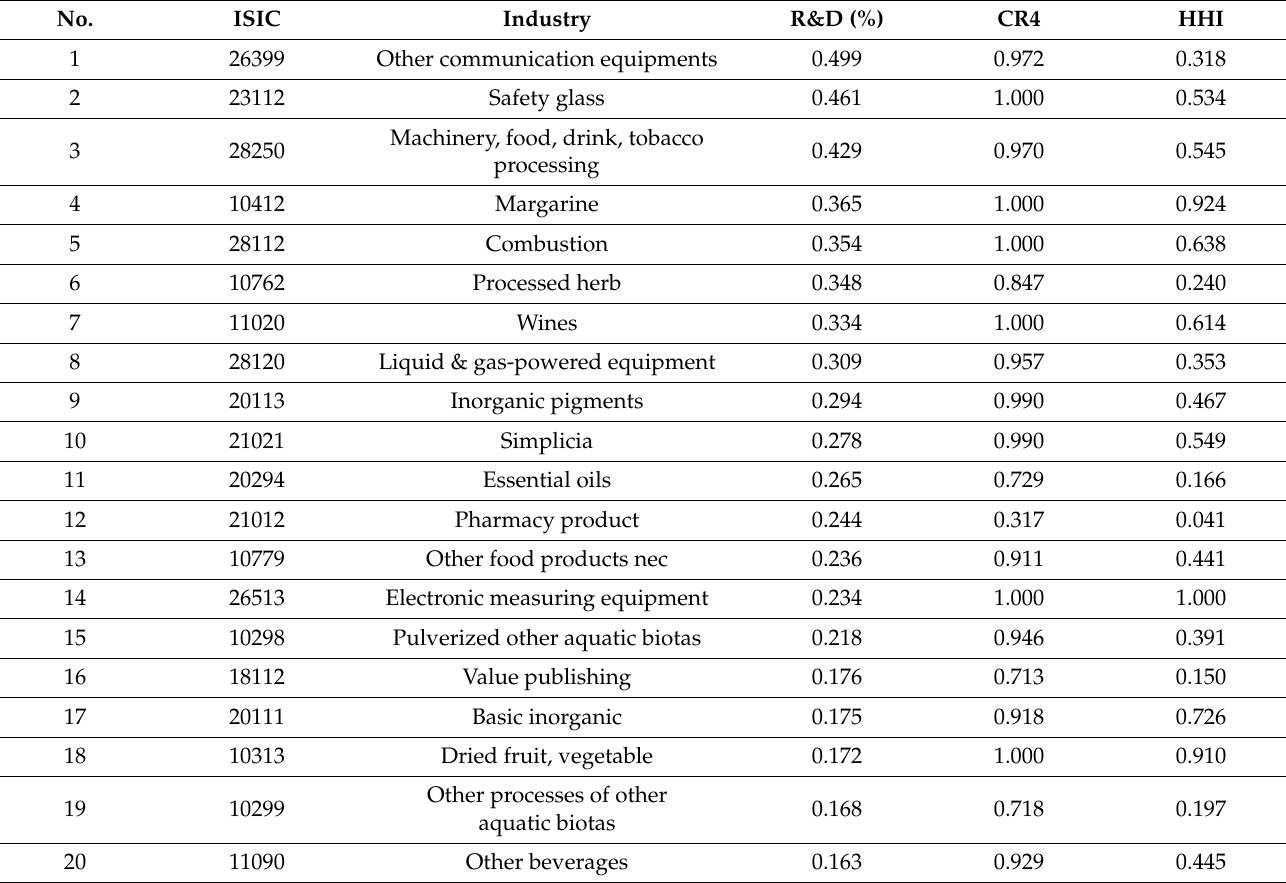
Table 2. 20 (Twenty) Subsectors with Highest Percentage R&D Expenditures (%), 1994–1995,